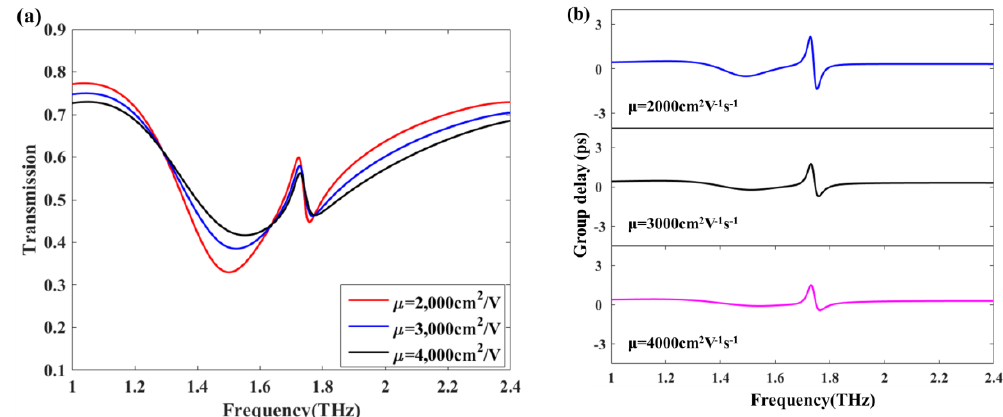
Figure 9. ( a ) The transmission and ( b ) group delay spectra of the hybrid metamaterial with different carrier mobility in graphene.